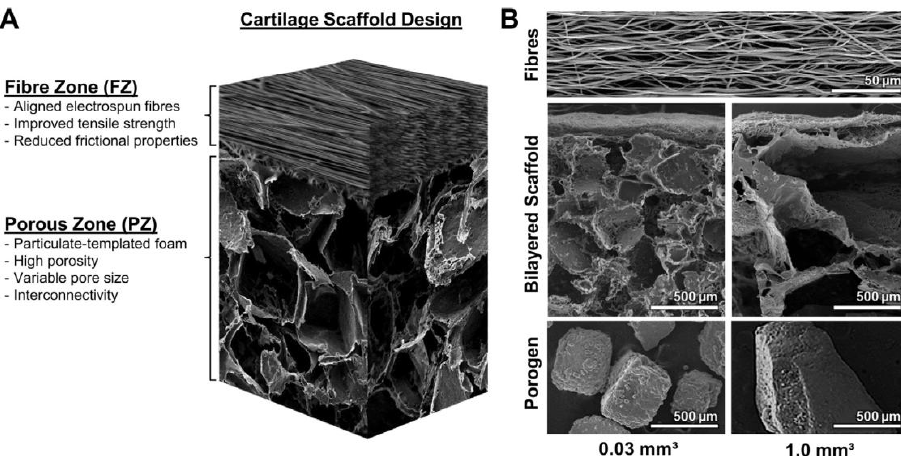
Figure 5. Bilayered cartilage scaffold ( A ) schematized by a diagram illustrating the electrospun fiber zone (FZ) deposited on a particulate-templated foam (PZ). The combination of the two distinct zones is designed to yield an anisotropic scaffold with a smooth articular surface and a more porous region for ECM deposition. ( B ) Electron microscopy images (top) of the aligned fiber zone that is shared between both scaffold varieties, (middle) the complete bilayered scaffolds with 0.3 mm 3 (left) and 1.0 mm 3 (right) pores, and (bottom) the sodium chloride porogens used to produce their respective